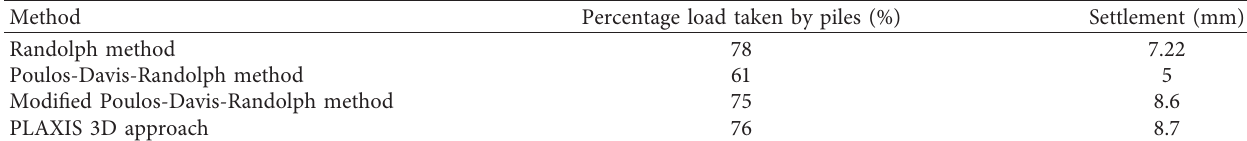
Table 4: Analysis result of case study (1).